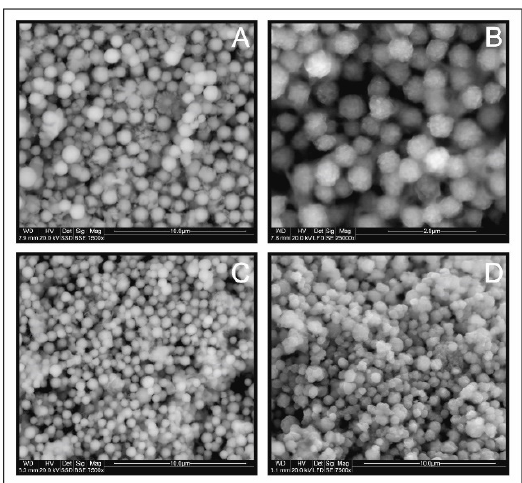
Figure 5. Scanning electron microscopy images of Cu 2 FeSnS 4 (CFTS) resulting from different synthesis times: ( A ) 1 day, ( B ) 3 days, ( C ) 1 week, ( D ) 2 weeks. All products consisted of spherical particles of relatively uniform average size.